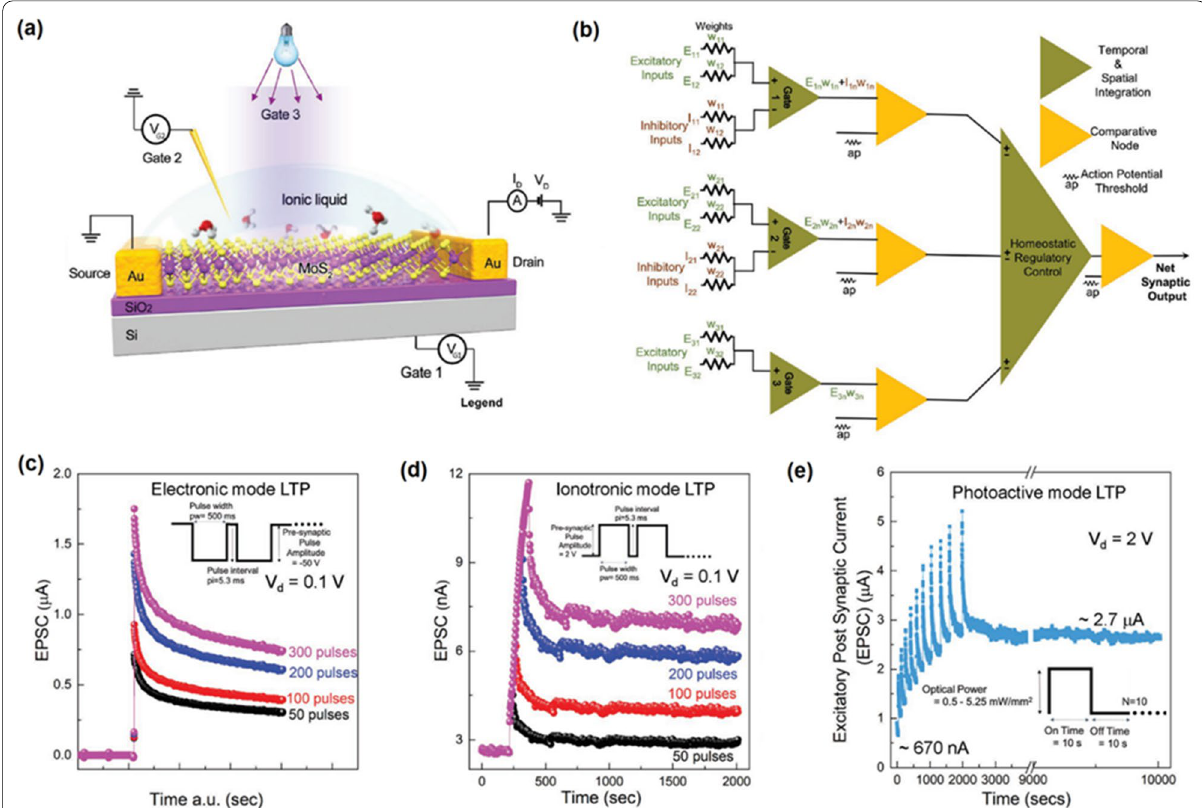
Fig. 18 Graphical scheme of triple modulated architecture of artificial 2D MoS 2 synaptic device. b The analogue circuit depicting the interplay between the various parameters for stimulation of synaptic plasticity. c The interplay between the Hebbian and synaptic plasticity in MoS 2 -based 2D synaptic device, which depicts the enhancement in the strength of long-term potentiation functionalities of device as he function of training by electronic-mode, d Ionotronic mode and e photovoltaic mode. In photovoltaic mode, the light intensity is altered (from 0.5 to 5.25 mW mm − 2 ) to enable training by optical pulses. Reprinted and reproduced with permission from